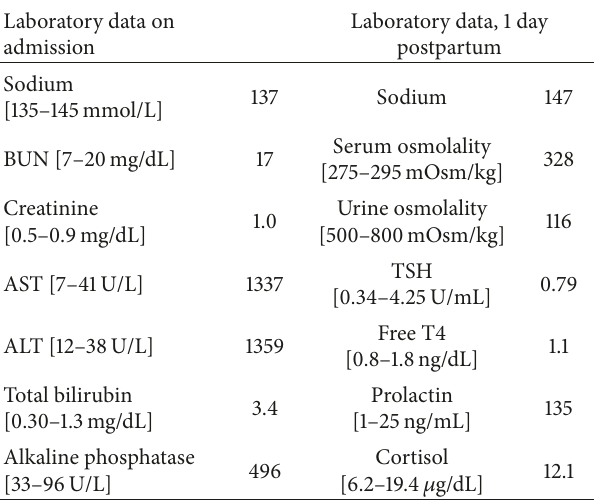
Table 1: Laboratory data for Case 1